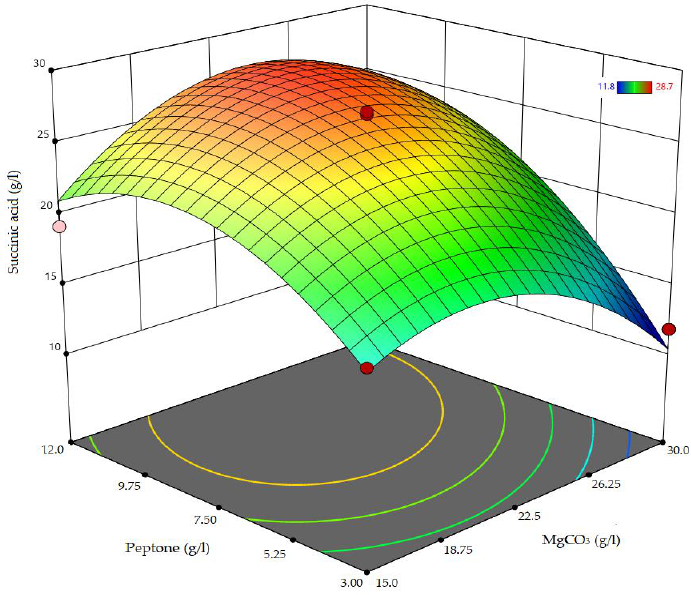
Figure 3. Response surface plot represents the effect of MgCO 3 and peptone on succinic acid pro- duction by E. gallinarum . production by E. gallinarum